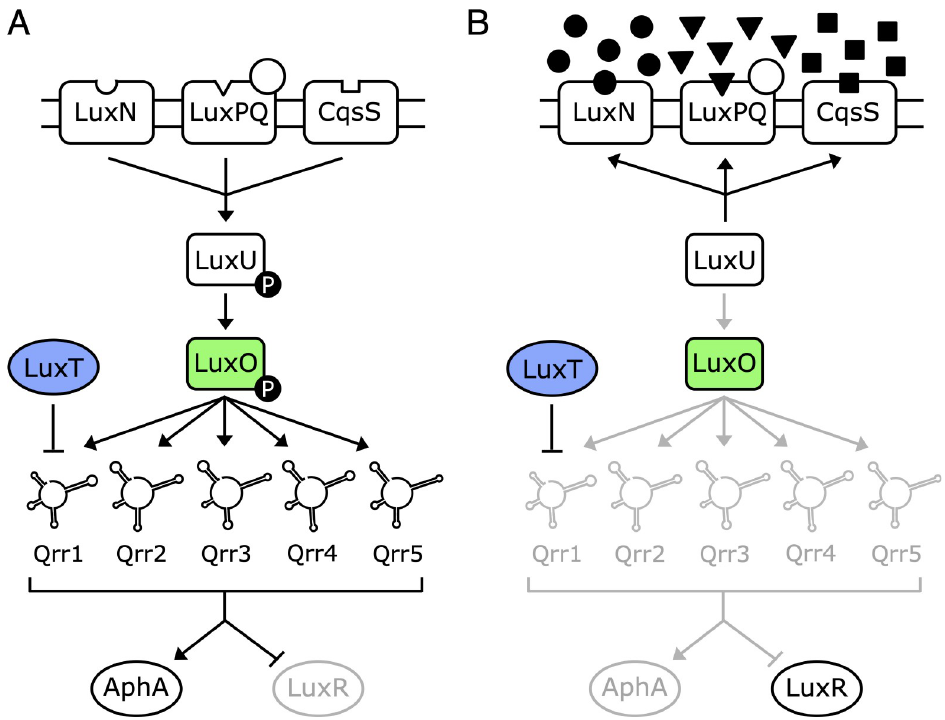
Fig 1. Model of the V . harveyi QS system. (A) LCD and (B) HCD. See text for